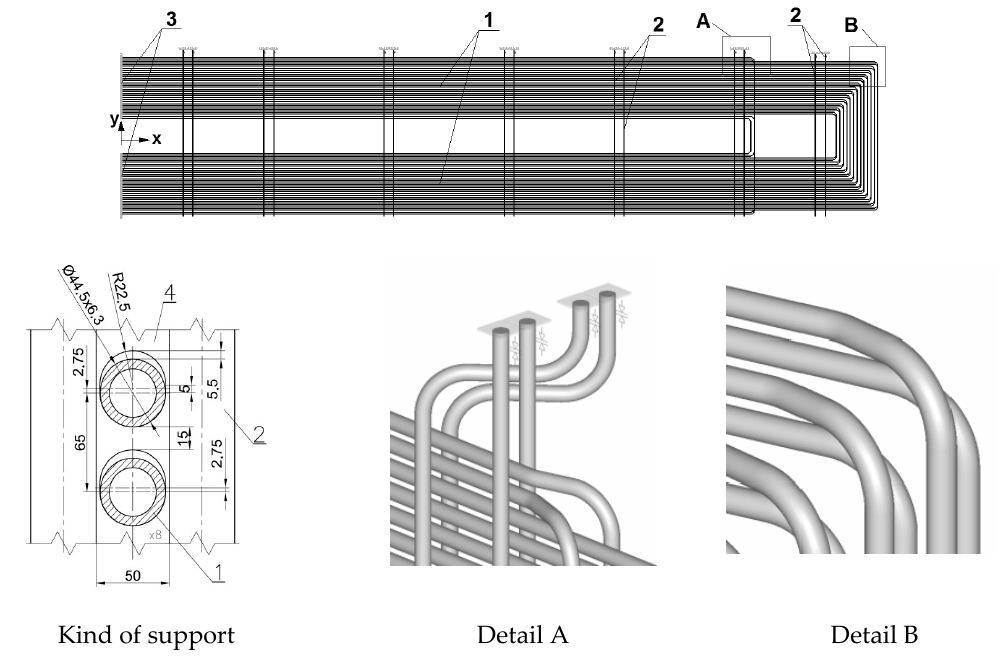
Figure 1. Superheater SH3 model (data from [7]).